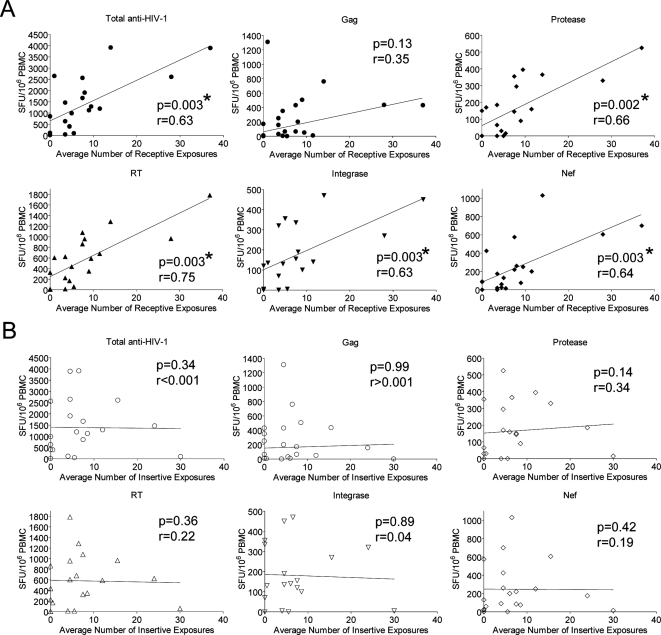
Direction of exposure and T cell IFN-γ response correlations.IFN-γ T cell responses from the viremic partner (VP) group were plotted against the corresponding average number of unprotected receptive (A) or insertive (B) anal exposures to a partner's HIV-1. Significant correlations (denoted by *) were determined by two-tailed nonparametric spearmans correlation, spearman r (r), and linear regression analysis was plotted as straight lines.